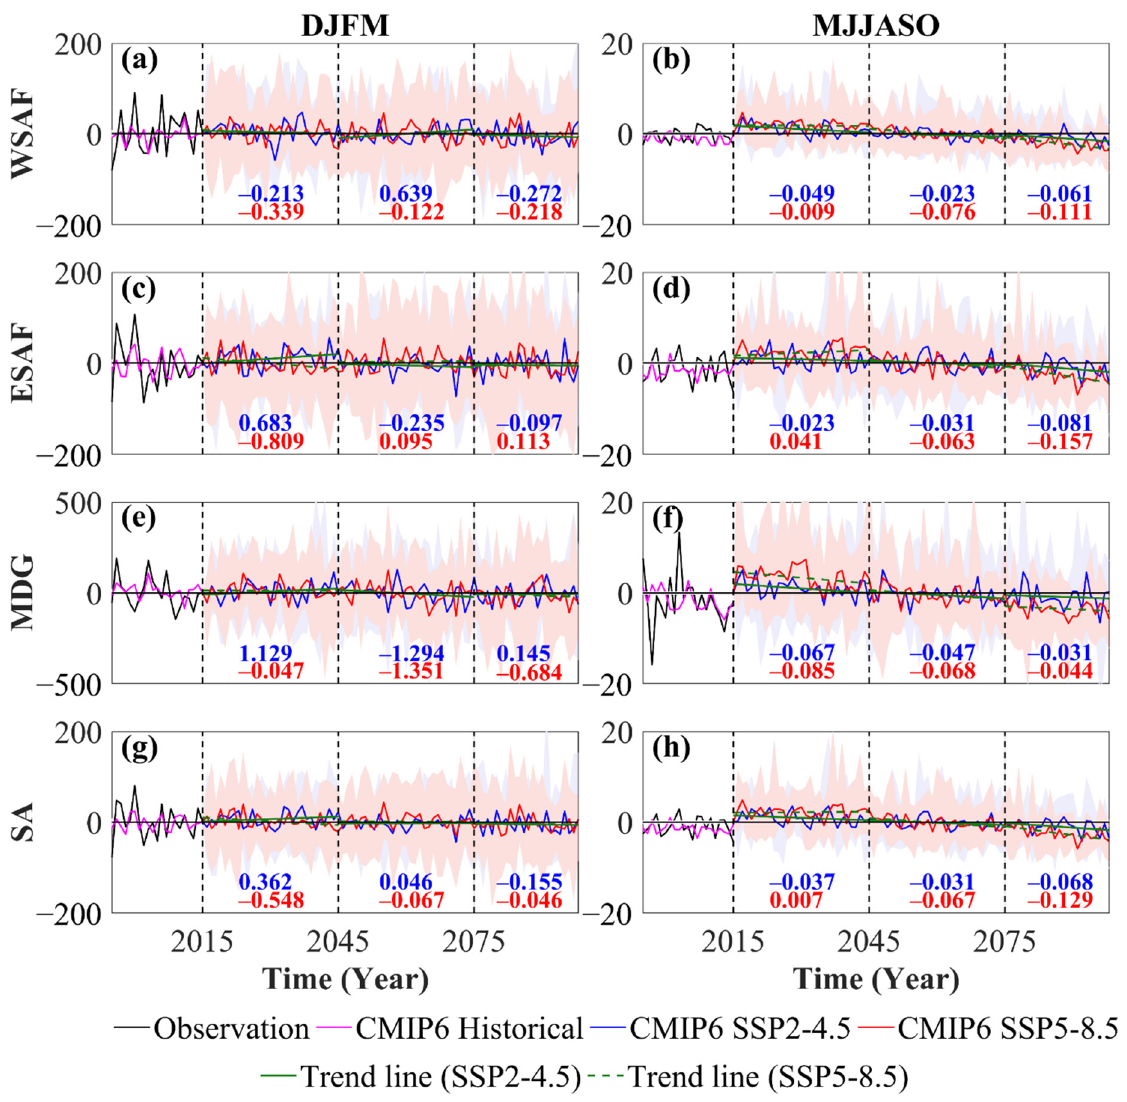
Figure 9. Projected seasonal precipitation anomaly (mm) and trend (mm/year) averaged over ( a , b ) WSAF; ( c , d ) ESAF; ( e , f ) MDG; and ( g , h ) SA for ( a , c , e , g ) DJFM; and ( b , d , f , h ) MJJASO, from 2015 to 2100. The black and magenta lines are the observation and CMIP6 historical trends (1995–2014), respectively. The blue and red lines are the CMIP6 SSP2-4.5 and SSP5-8.5 trends, respectively. Each time section’s trend lines are green, with the solid (dashed) green line for SSP2-4.5 (SSP5-8.5). The slope for each time section is shown in red (SSP2-4.5) and blue (SSP5-8.5). The reddish and bluish shadings are the data spread.